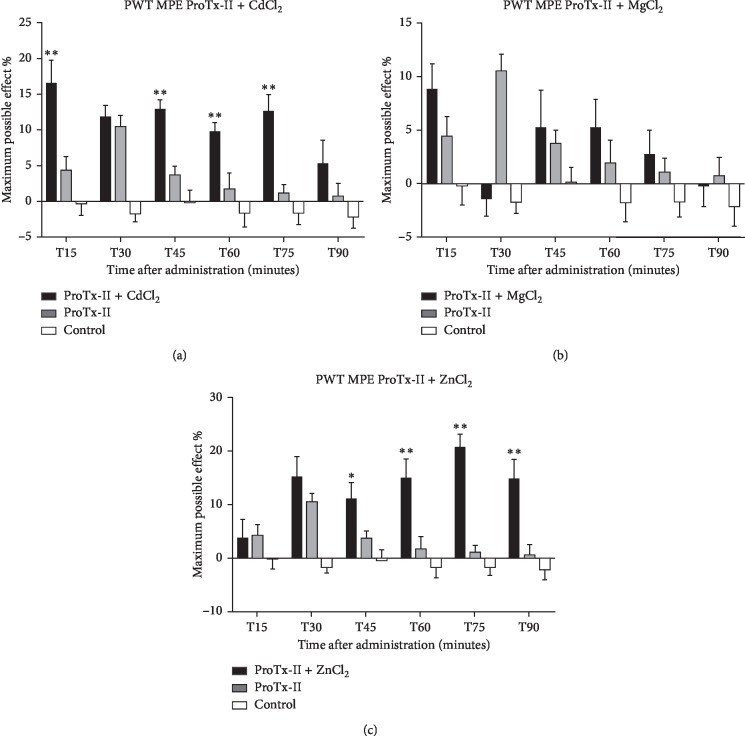
The maximum possible effect over the paw withdrawal threshold test expressed in % and represented as mean ± SEM over a period of 90 minutes. Significant difference from the control groups was noted with ∗ for a p value < 0.05, respectively, and ∗∗ for a p value < 0.01. (a) Protoxin-II and CdCl2 with Protoxin-II as positive control and saline as negative control. (b) Protoxin-II and MgCl2 with Protoxin-II as positive control and saline as negative control. (c) Protoxin-II and ZnCl2 with Protoxin-II as positive control and saline as negative control.